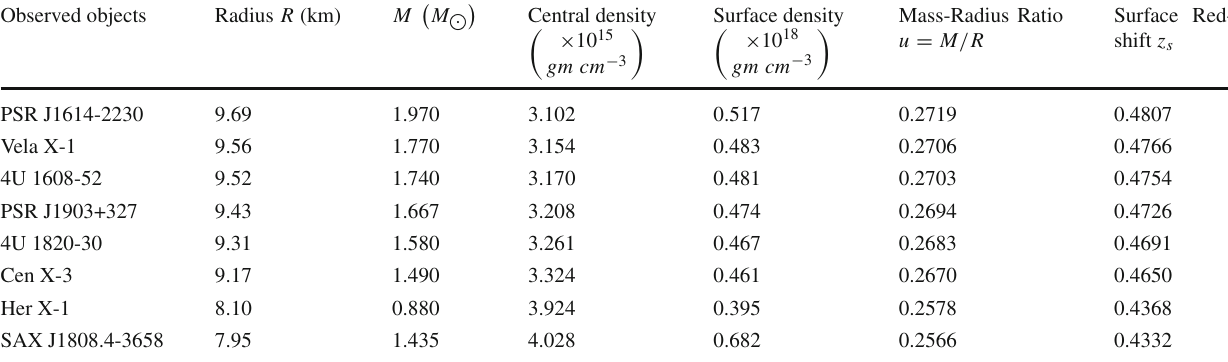
Table 1 Physical parameters for different anisotropic astrophysical models for α 1 = 0 . 45 and α 2 = 0 . 001 Observed